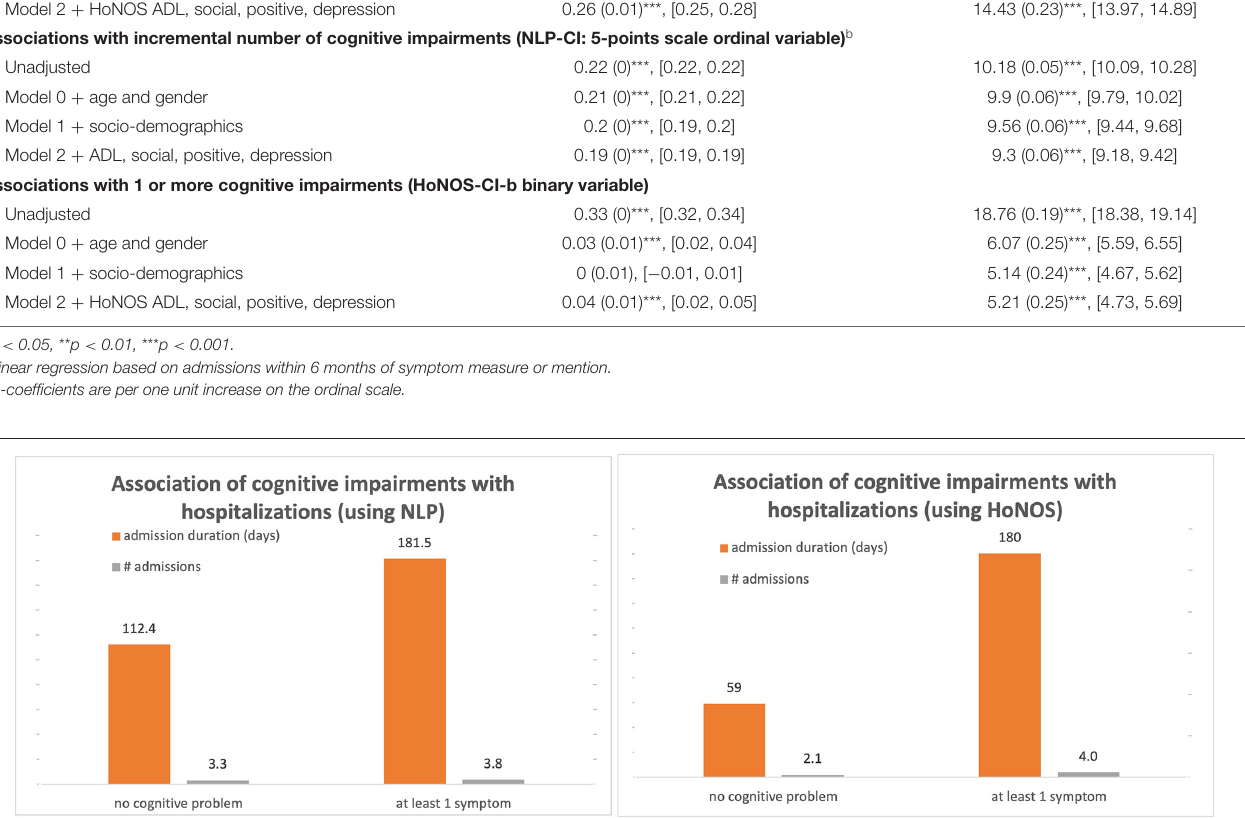
TABLE 5 | Association between number of cognitive impairments (estimated using NLP and HoNOS) with mental health hospital admission and duration of admission between 2007 and 2020 (Sample B). Number of ward admissions a Duration of inpatient admission (days) a β -coeff (SE), CI 95% β -coeff (SE), CI 95% Associations with 1 or more cognitive impairments (NLP-CI-b: binary variable)